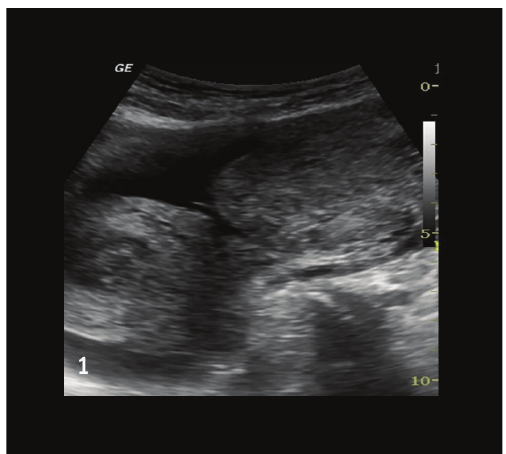
Figure 1: Unicornuate uterus with noncommunicating ruptured rudimentary horn (both are empty, no products of conception seen).